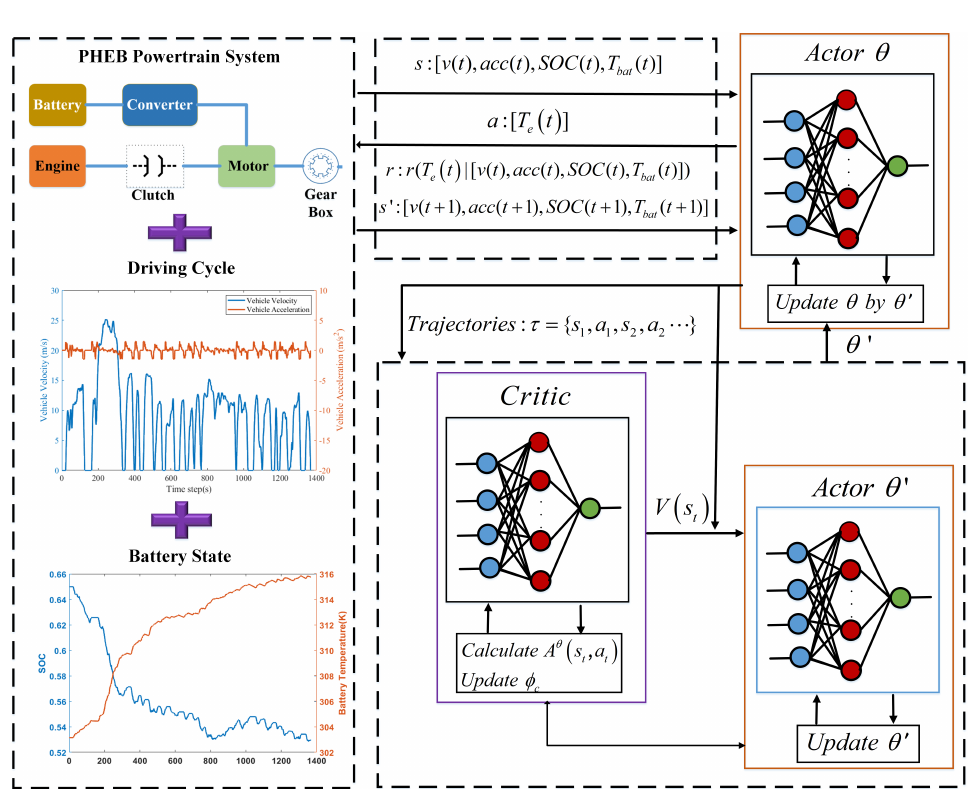
Figure 6. PPO-based